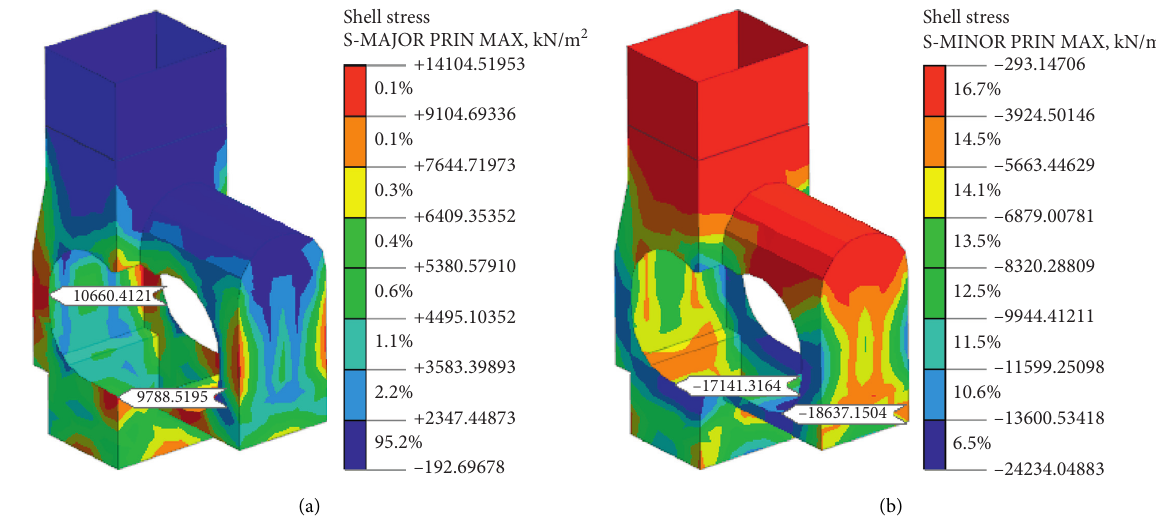
Figure 11: Distribution of maximum and minimum principal stress in the supporting structure of cross channel and